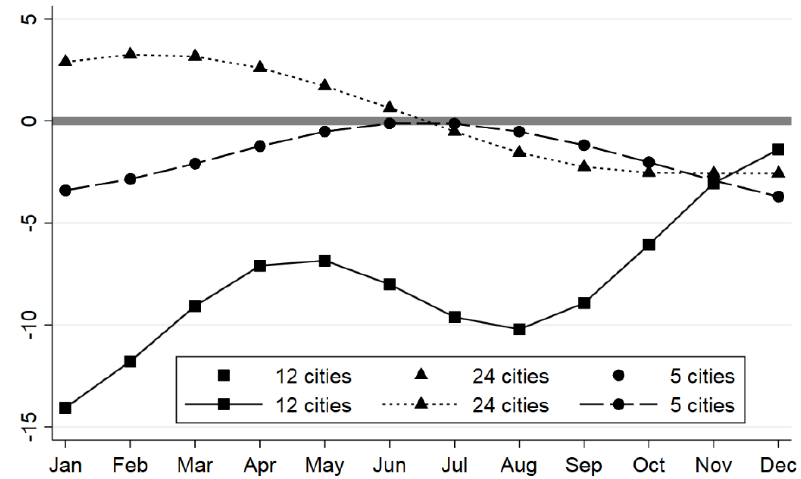
Figure 3. Trends of long-term changes in AQI in three types of cities. (Note: A total of 12 cities had severe outbreaks, 24 cities had few confirmed cases, and 5 cities had secondary outbreaks. The Y − axis indicates the value of the long-term change of AQI, and the X − axis indicates the month.)